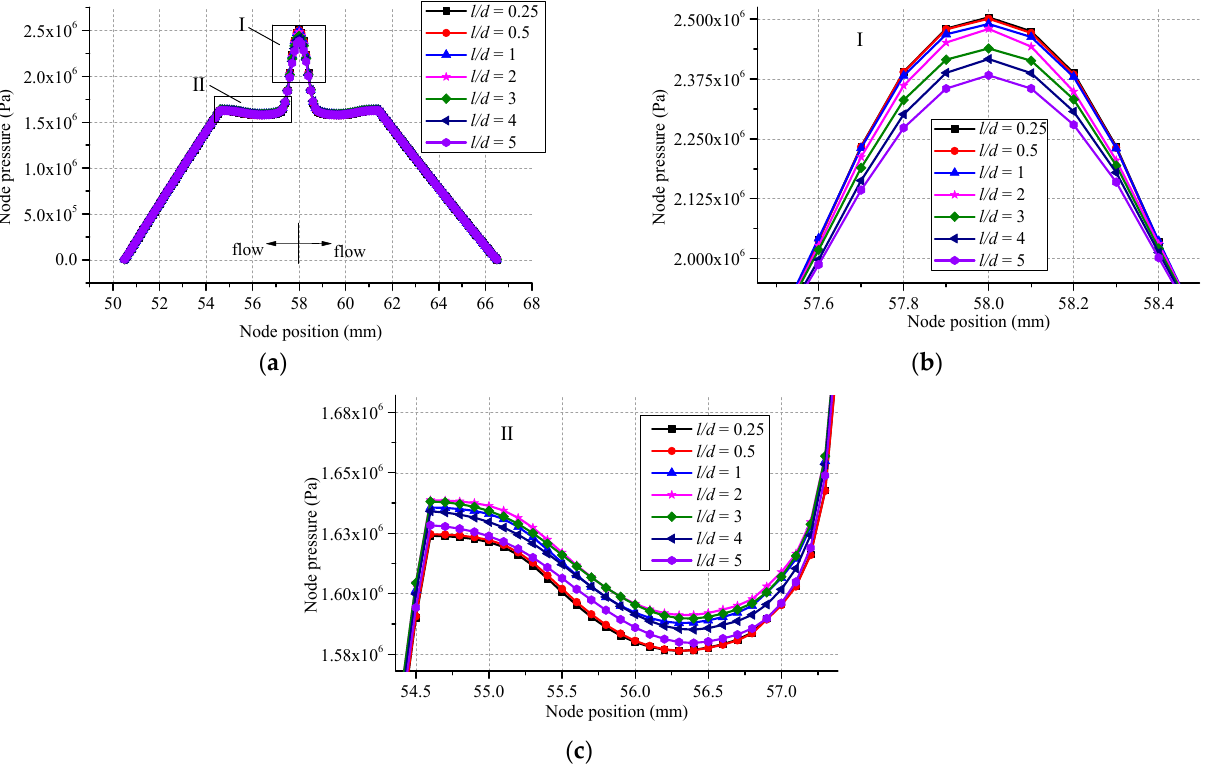
Figure 10. Pressure patterns of various OLDRs along the line of a 1 – a 2 . ( a ) Node pressures of various OLDRs along the line of a 1 – a 2 ; ( b ) local enlarged view of Ⅰ ; ( c ) local enlarged view of Ⅱ .